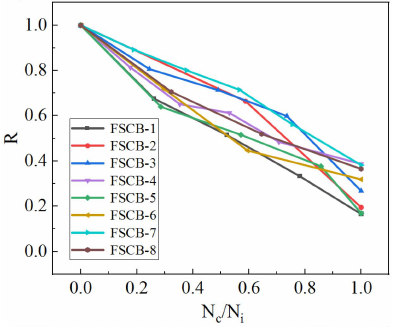
Figure 12. Stiffness degeneration